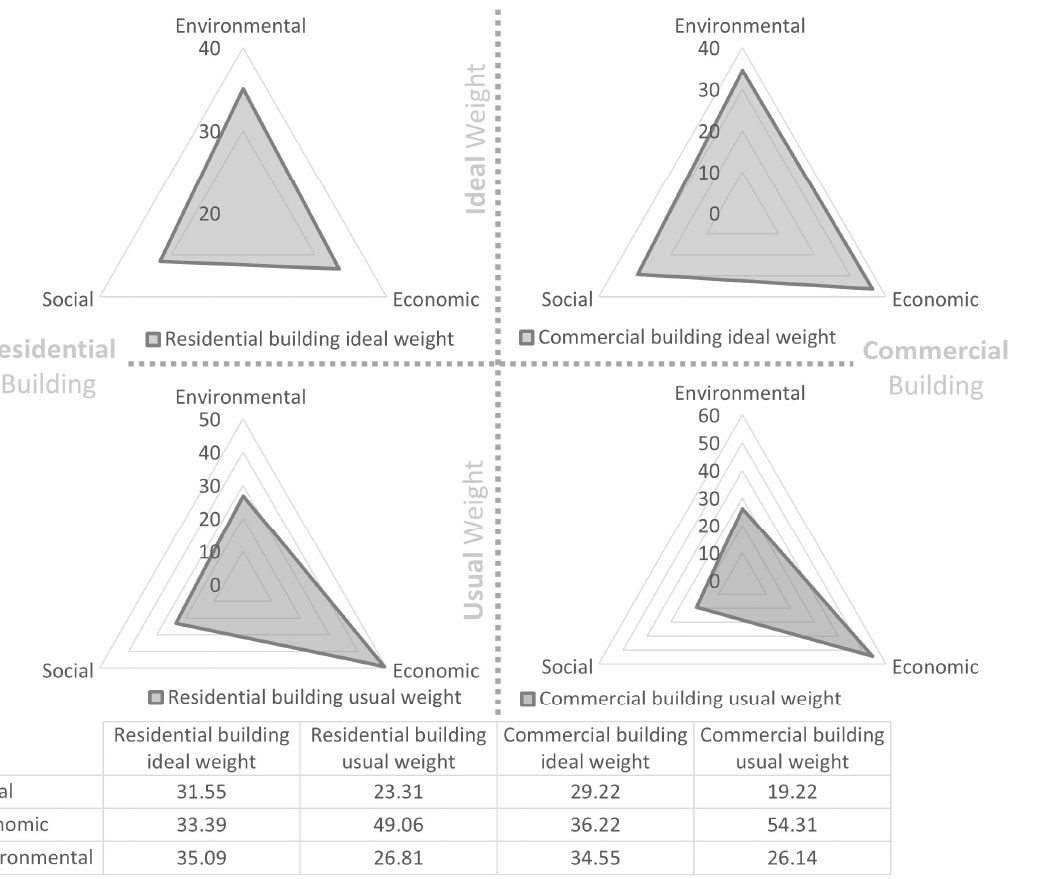
Figure 2. Radar chart showing typical and ideal weights of three sustainably dimensions.